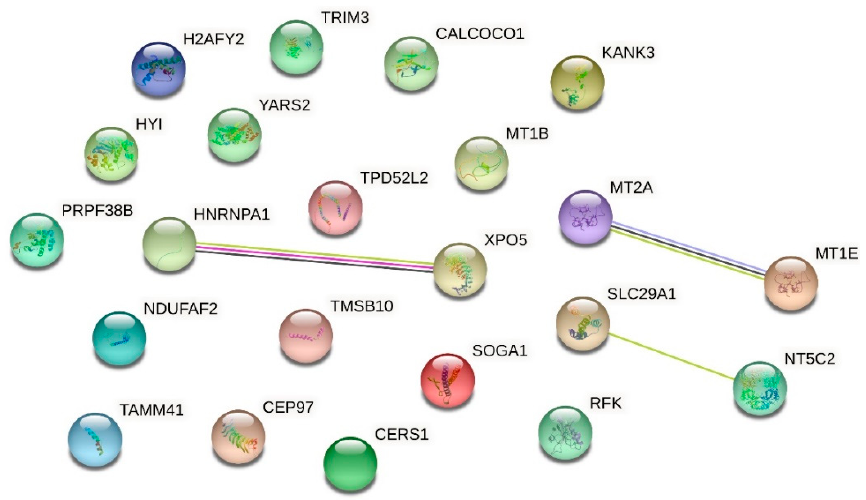
Figure 8. Network of up-regulated proteins in HMEC-1 exposed to urea. The network, obtained with the software STRING, includes proteins that were found to be up-regulated in cells treated with 5 g/L urea compared to cells treated with 0.25 g/L urea for 72 h.